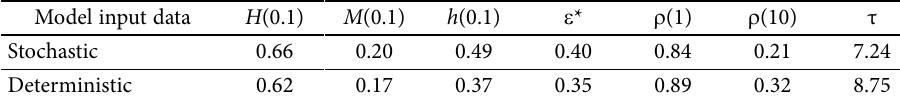
Table 1. Information and statistical